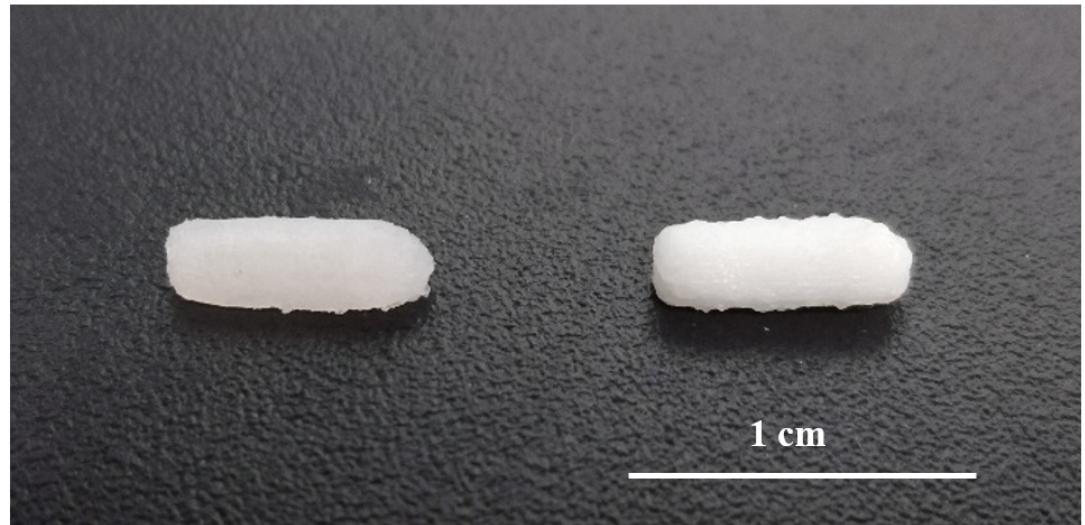
Figure 2. Picture of 3D printed suppositories without barium sulphate (left) and with barium sulphate (right).